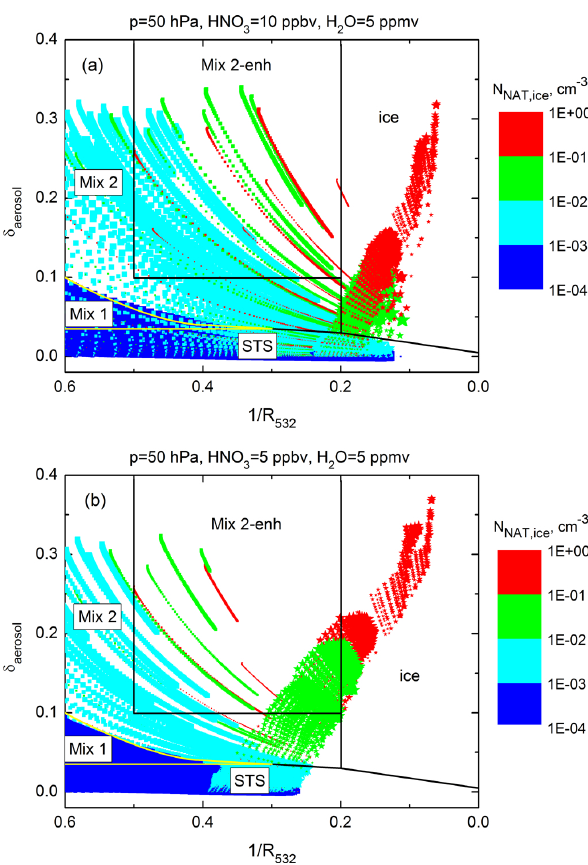
Fig. 10. Theoretical calculations of CALIOP optical signals for var- ious liquid/NAT mixtures and ice computed for the (a) standard and (b) denitrified conditions. Points are color-coded by particle number densities as indicated in scale on right.